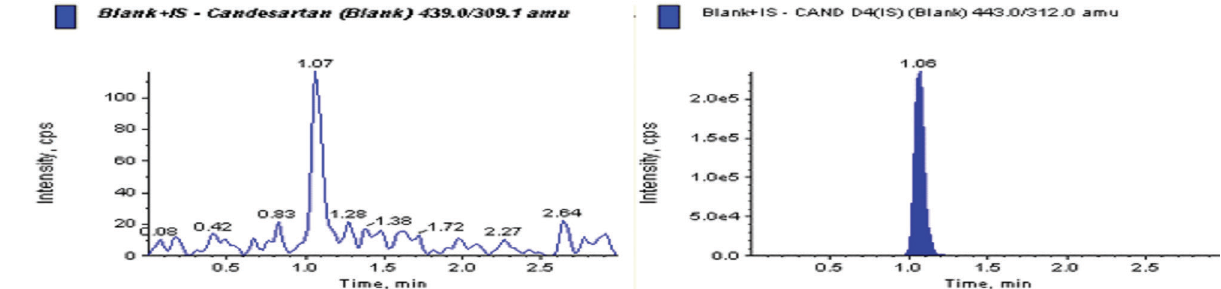
FIGURE 5 - Representative chromatogram of blank plasma sample with CAN- IS.